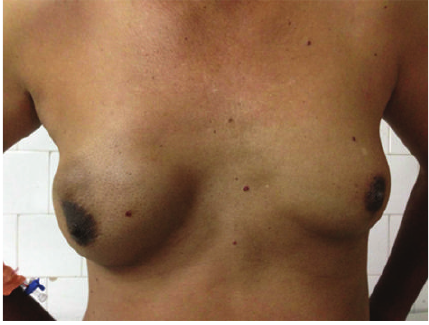
Figure 3: Histopathology of the excision biopsy specimen shows infiltrating papillary carcinoma with atypical nuclei, chromatin clumping, and severe pleomorphism (H&E staining, magnification 40x).